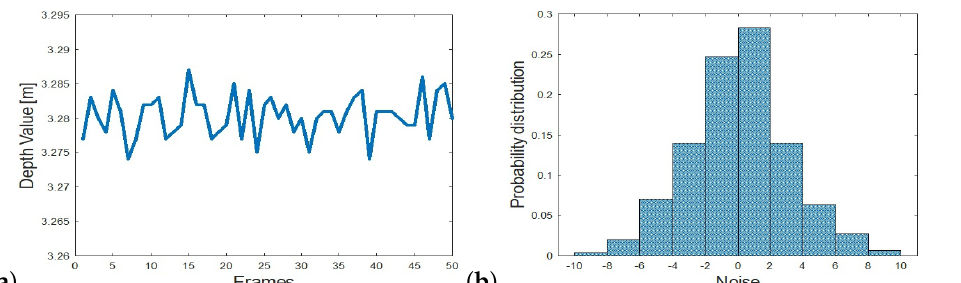
Figure 6. ( a ) Depth response at a pixel acquired over 50 frames by a KinectV2 [31]. ( b ) Histogram of noise at the pixel. Noise magnitude is defined as the variance of depth values and noise variance is defined as the variance of the absolute deviation values. In this example, noise magnitude is µ = 0.094 cm, and noise variance is σ 2 = 0.036 cm.